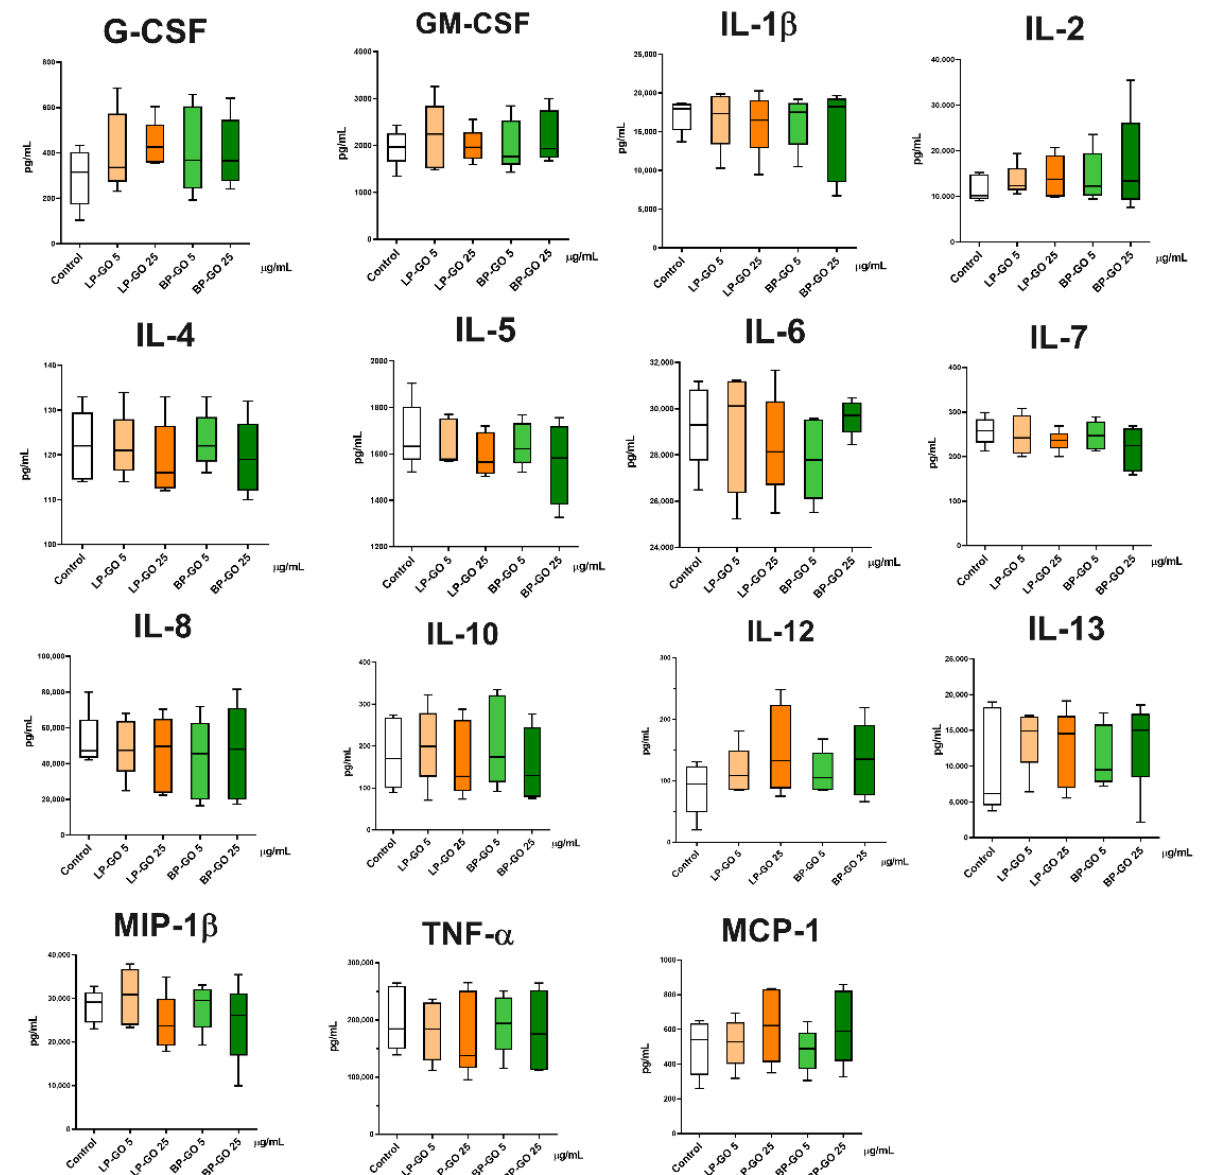
Figure 9. Cytokine concentrations in Th17-polarized cell culture supernatants after incubation with graphene oxide nanoparticles, n = 5, Me